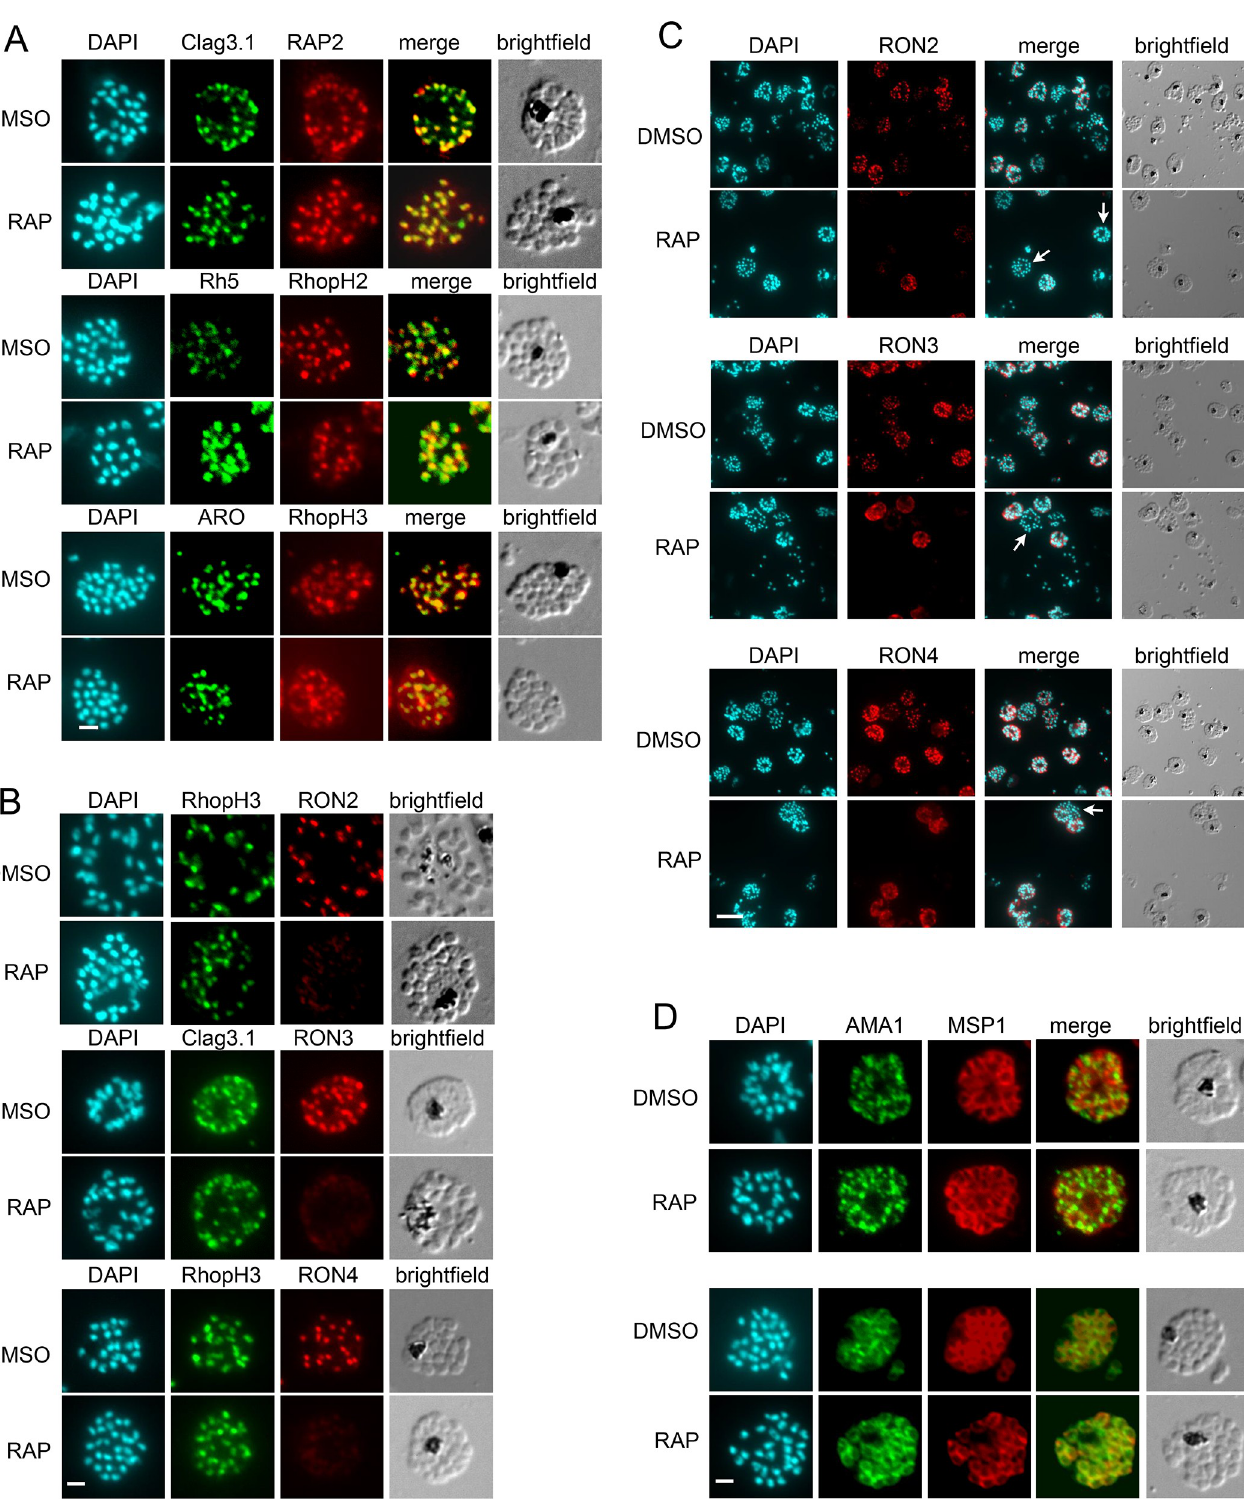
Fig 4. Disruption of RAMA leads to selective mislocalisation of some but not all rhoptry proteins. (A) IFA showing that the staining profile of RAP2, RhopH1/Clag3.1, Rh5, RhopH2, ARO and RhopH3 was unaltered between DMSO- and RAP-treated RAMAloxP clone 9C10 schizonts. Scale bar, 2 μ m. (B) IFA showing that, whilst RhopH3 and RhopH1/Clag3.1 staining was unaffected by RAMA disruption, RON2, RON3 and RON4 staining was modified in RAP- treated RAMAloxP clone 9C10 schizonts. In all cases, the staining was much weaker in the RAMA Δ E2 parasites and lacked the characteristically